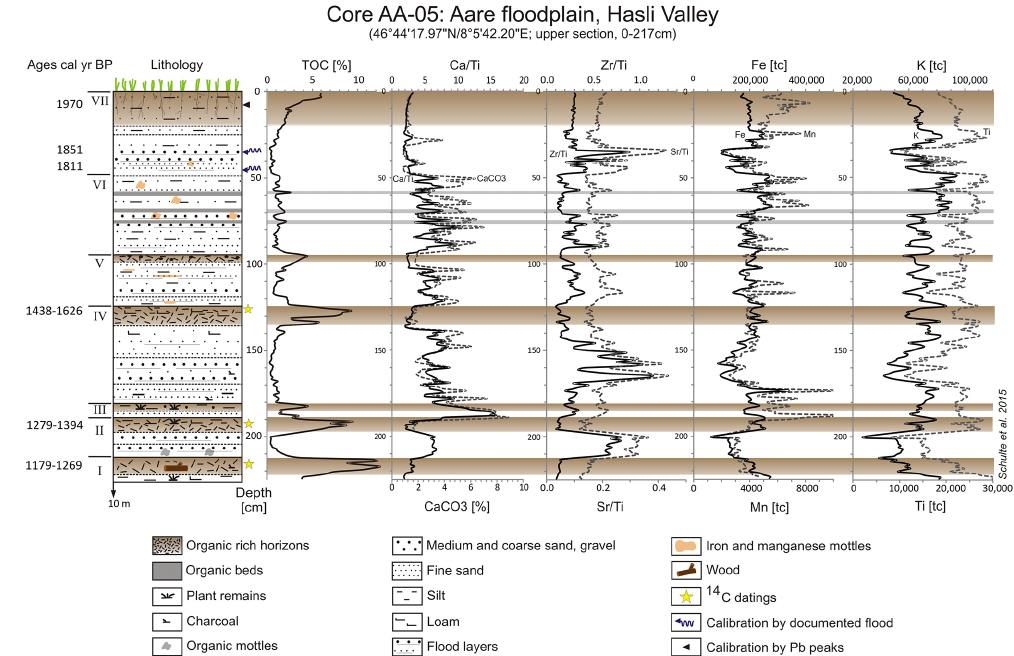
Figure 2. Lithology, chronology and geochemical stratigraphy of key core AA-05. The bars represent organic horizons and beds.